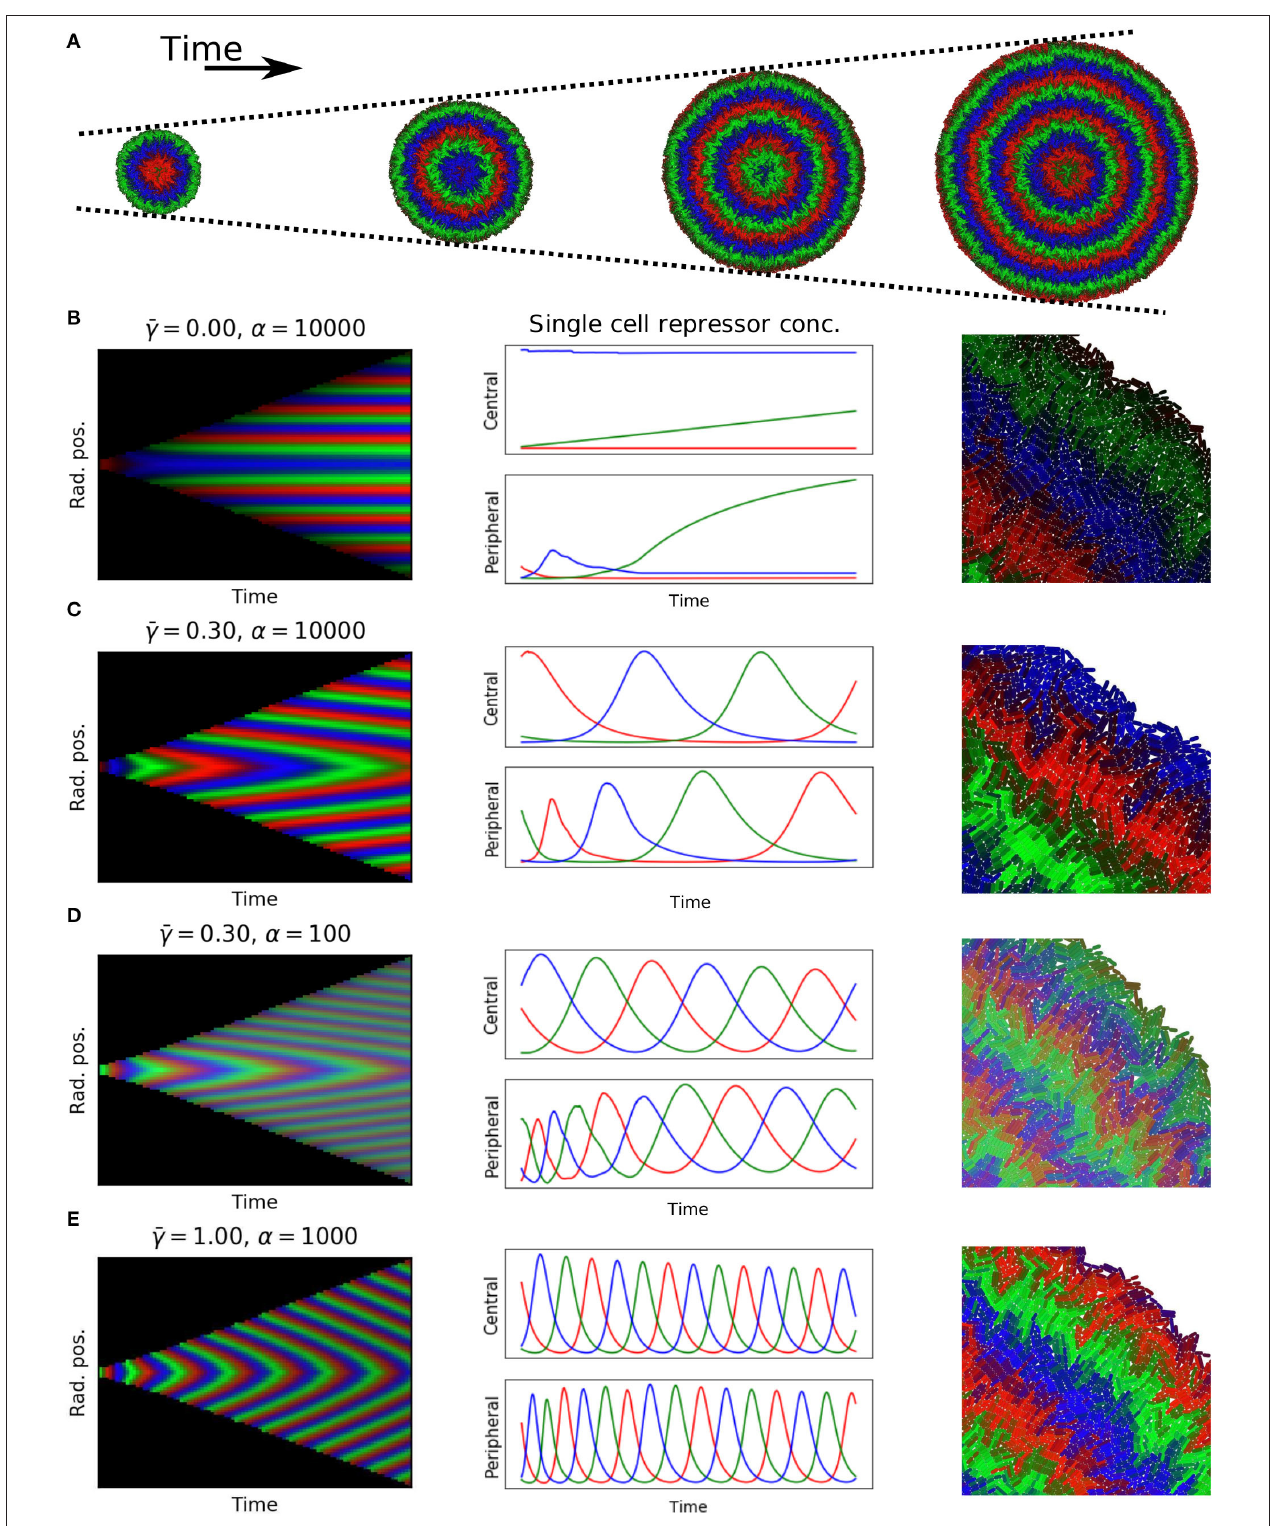
FIGURE 7 | Simulations of growing colonies. (A) Colonies with 5,000, 20,000, 35,000, and 50,000 cells, equally spaced 9.3 doubling times apart, with ¯ γ = 0.3, α =10.000. (B–E) Each panel shows: kymograph of repressor concentrations (51 doublings, approximately 60,000 cells); time dynamics for central cell and peripheral cell in colony; close up of edge of colony at end of experiment. Parameters: (B) ¯ γ = 0, α = 10,000. (C) ¯ γ = 0.3, α = 10,000. (D) ¯ γ = 0.3, α = 100. (E) ¯ γ = 1.0, α = 1,000.